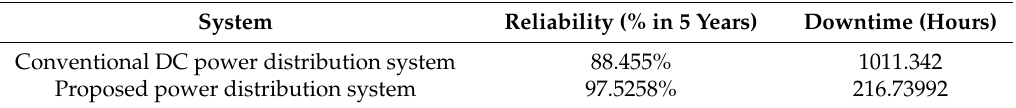
Table 4. Reliability comparison between a conventional power distribution system and the proposed power distribution